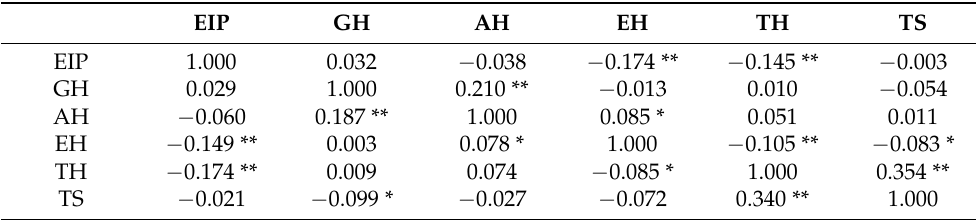
Table 3. Pearson and Spearman correlation coefficients.